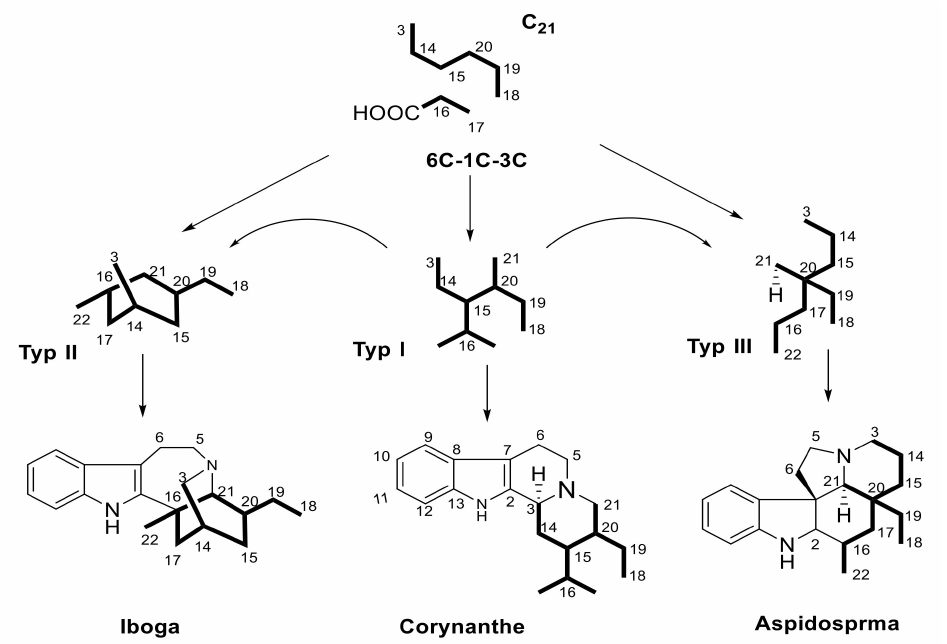
Figure 1. Biogenetic numbering rule as adopted from LeMen and